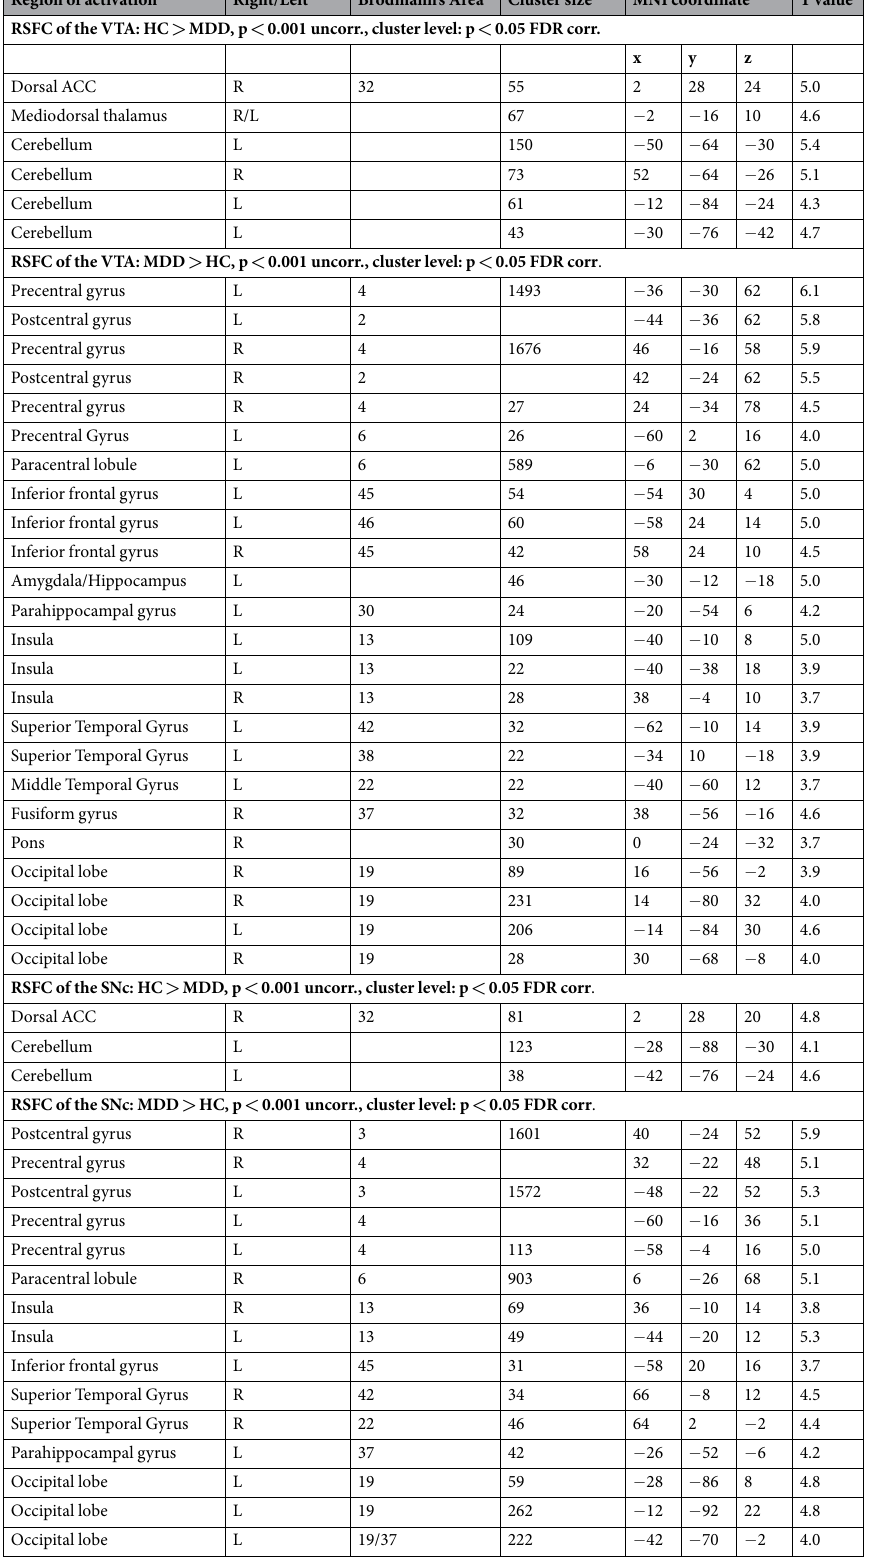
Table 1. Comparison of the resting-state functional connectivity between patients with MDD and healthy controls with seed regions in the dopaminergic ventral tegmental area (VTA) as well as substantia nigra pars compacta